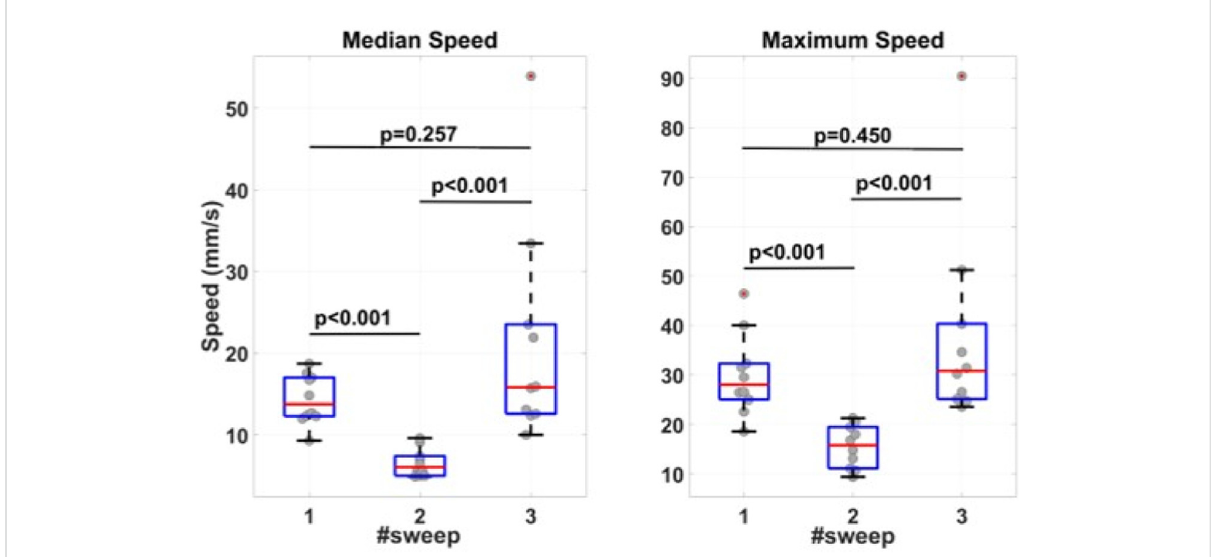
FIGURE 9 Measured median and maximum sweep speeds. Before the fi rst sweep, the participants were told to perform the sweep at a speed convenient for the participant. Before the second sweep, the participants had been suggested to keep the sweep speed at 10 mm/s. Before the third sweep, the participants were again asked to move the transducer at a comfortable speed.